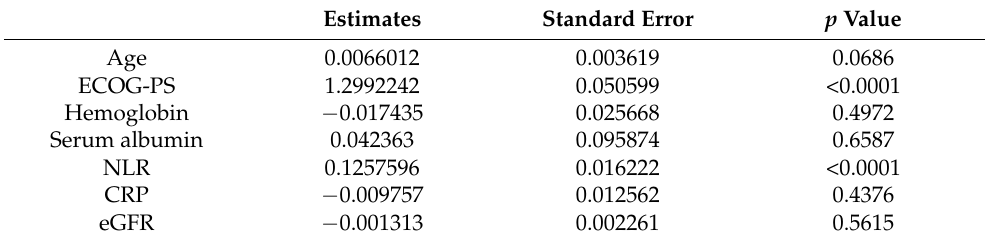
Table 3. Multivariate analysis (multiple regression analysis) of factors linking to the SARC-F score.